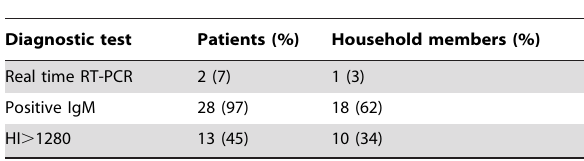
Table 2. Summary of dengue diagnostic results obtained from patients and their corresponding/accompanying household members.